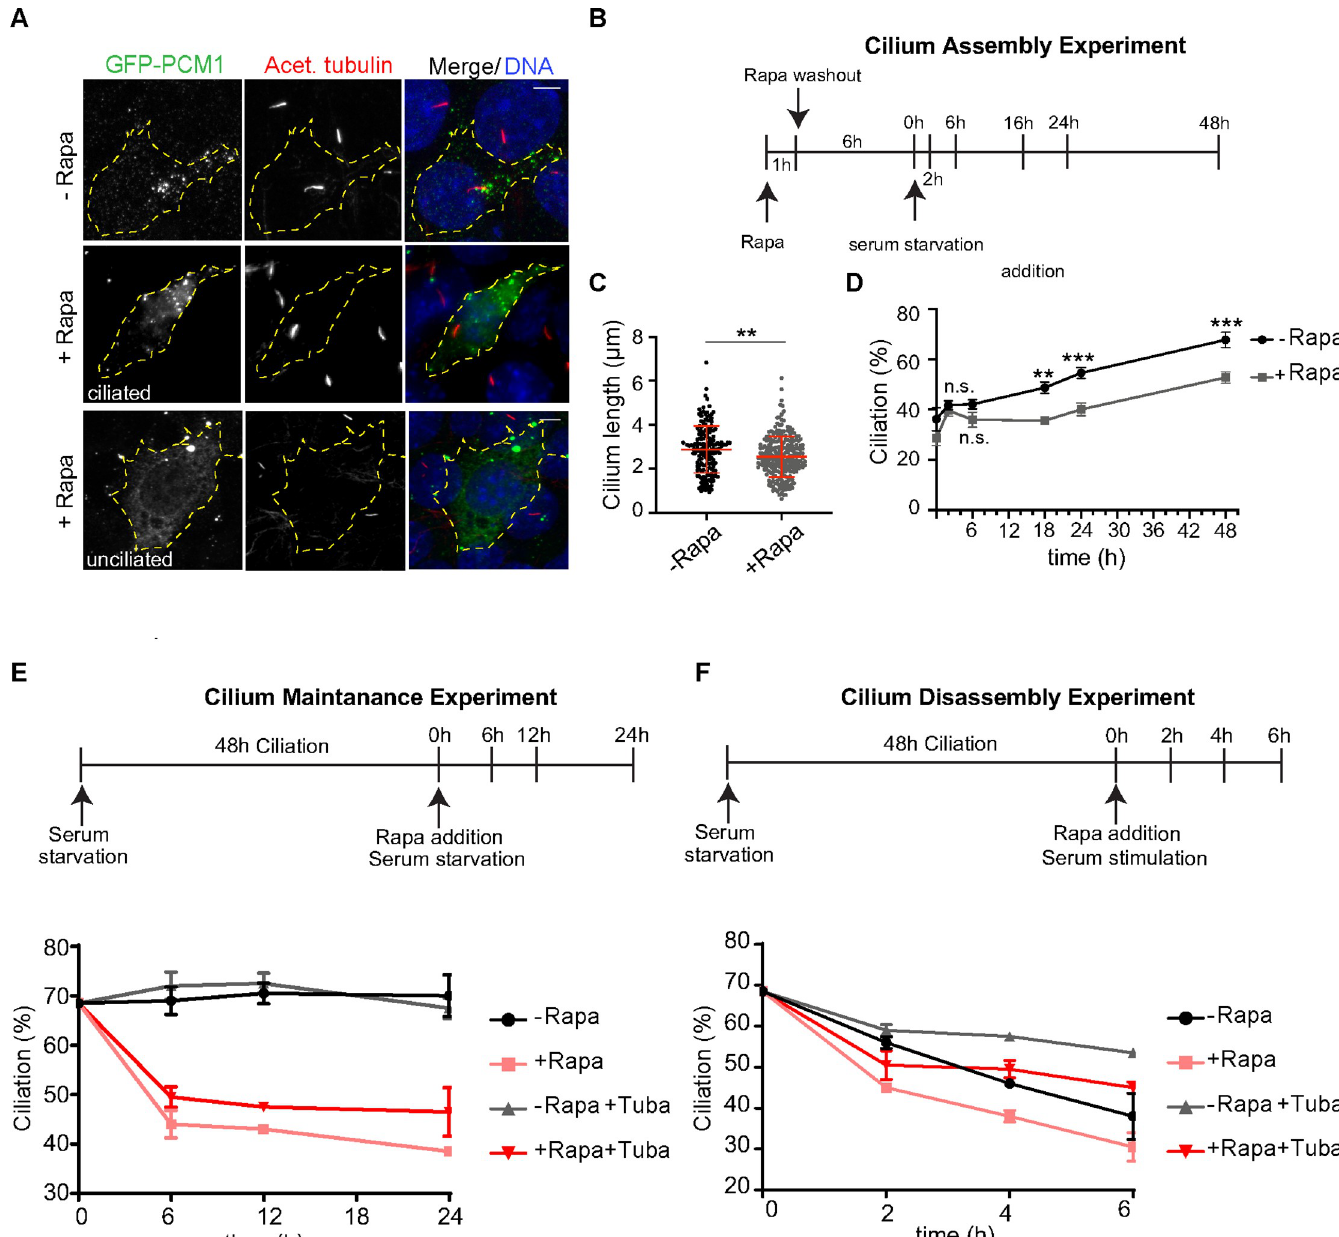
Fig 4. Pericentrosomal satellite clustering is required for efficient cilium assembly, maintenance, and disassembly. (A, B, C) Effect of peripheral satellite clustering on cilium assembly dynamics and cilium length. (A) Representative images of ciliated and unciliated cells with peripheral satellite clustering relative to ciliated